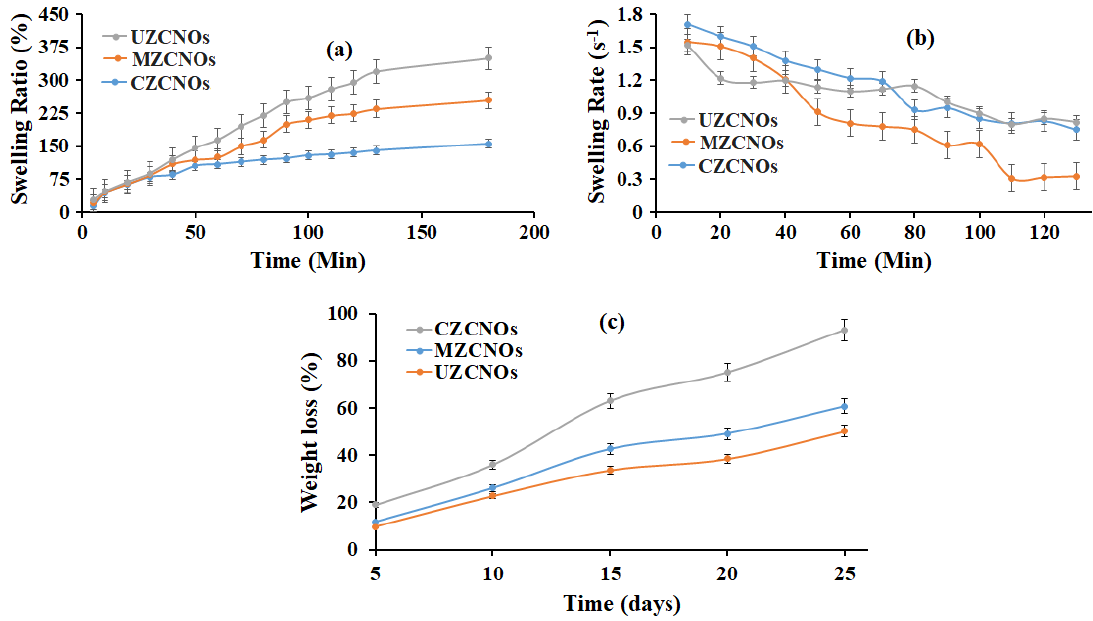
Figure 5. ( a ) Swelling ratio, ( b ) swelling rate, and ( c ) degradation curves of (i) CZCNO, MZCNOs, and UZCNOs hydrogels, respectively, in DMEM (pH 7.4) at room temperature.